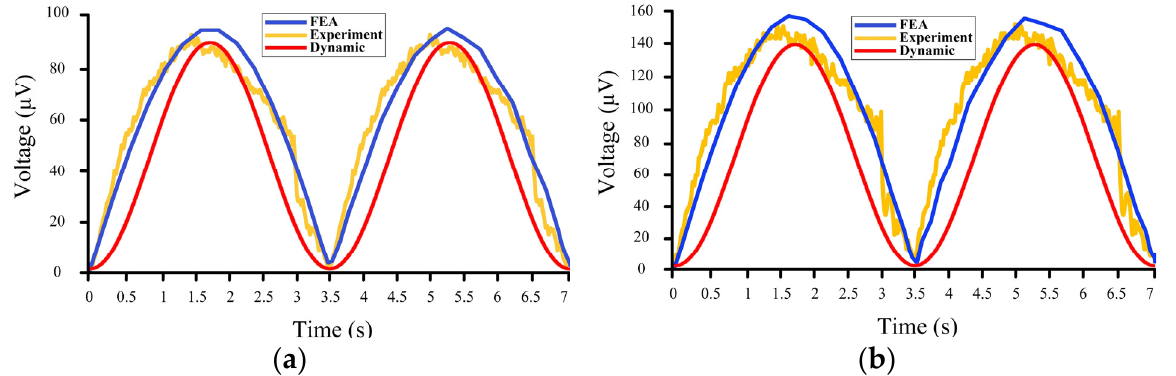
Table 2. Comparison of the results.